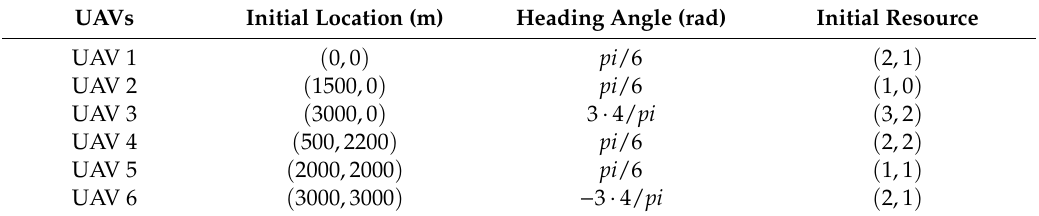
Table 2. The initial information of the unmanned aerial vehicles (UAVs).